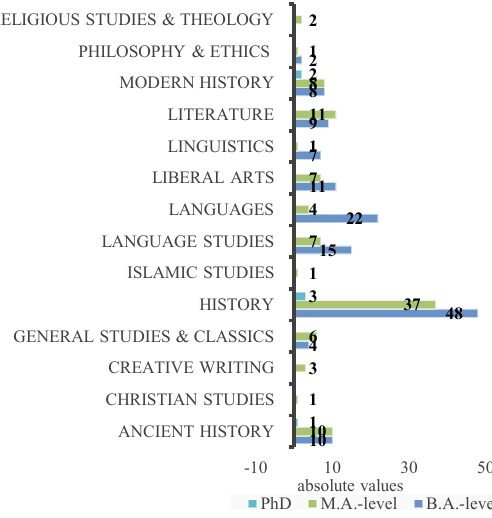
Figure 4. Domains of DCH in humanities